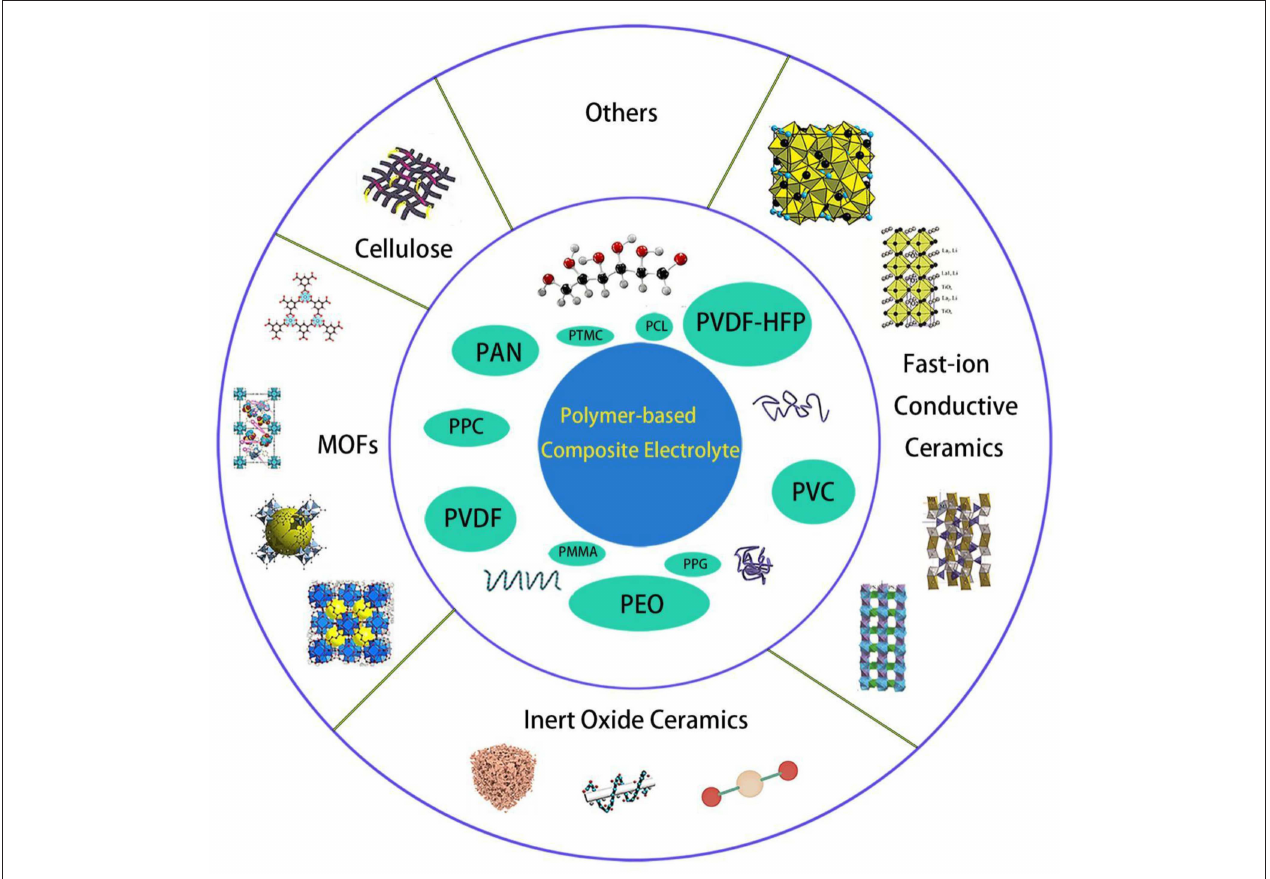
FIGURE 1 | Categories of the existing polymer-based composite solid